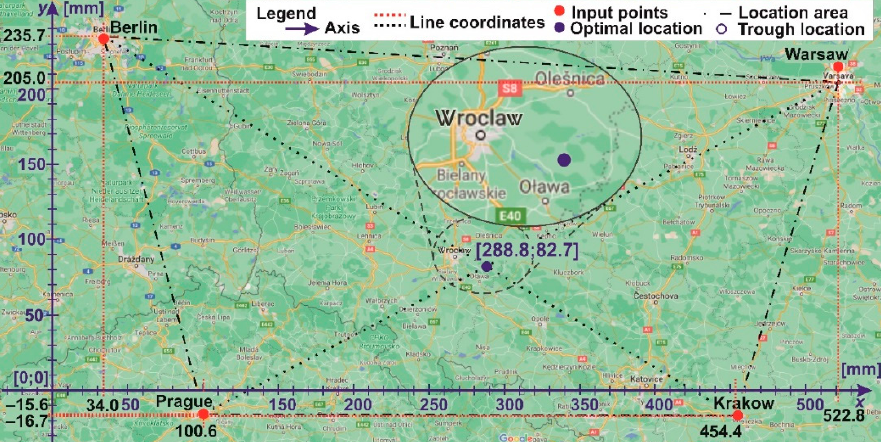
Figure 6. Graphical display of a task solution that matches the diagonal intersection.